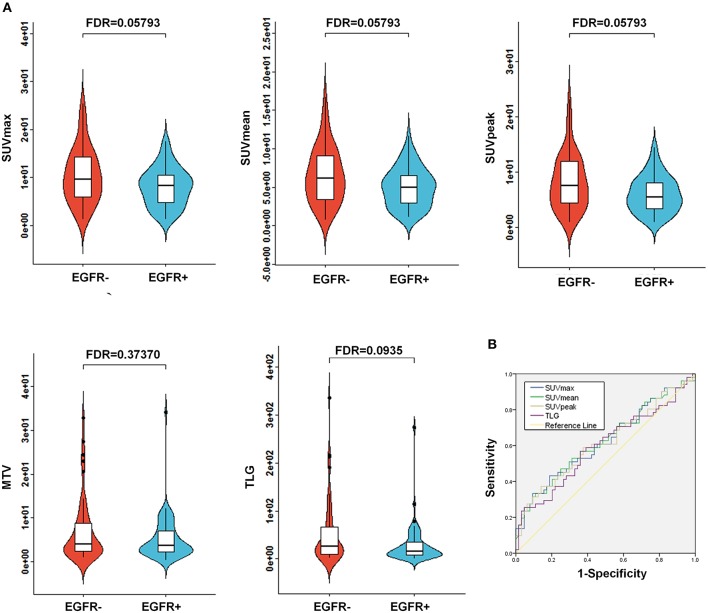
Comparison of conventional PET variables between EGFR mutated cases and wild type EGFR cases in NSCLC. (A) Box plots for SUVmax, SUVmean, SUVpeak, MTV, and TLG between EGFR mutations. As illustrated, significant differences were exhibited for SUVmax, SUVmean, SUVpeak, and TLG between EGFR mutations. Whereas, no marked variations were observed for MTV between the EGFR mutation positive (EGFR+) subgroup and the EGFR mutation negative (EGFR-) subgroup. (B) Receiver operating characteristic (ROC) curves for the prediction of EGFR mutations using the identified significant conventional PET parameters, including SUVmax, SUVmean, SUVpeak, and TLG. The area under the curve (AUC) was calculated for SUVmax, SUVmean, SUVpeak, and TLG, respectively. AUC, the area under the curve; EGFR, epidermal growth factor receptor; PET, positron emission tomography; CT, computed tomography; NSCLC, non-small cell lung cancer; SUV, standardized uptake value; MTV, metabolic tumor volume; TLG, total lesion glycolysis.